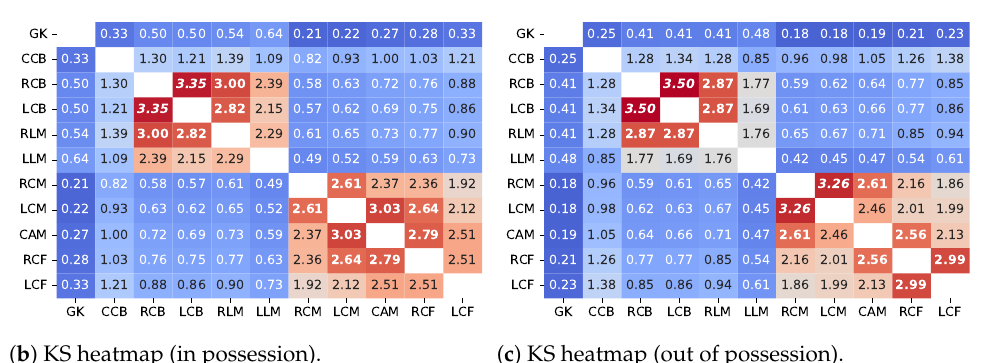
Figure 3. Players’ Voronoi area probability density function in the 3-4-1-2 team formation. ( Note: Violin plots ( a ) and heatmaps ( b , c ) comparing players’ Voronoi area probability density function (less similar in blue, more similar in red). The differences that are statistically not relevant are highlighted in bold